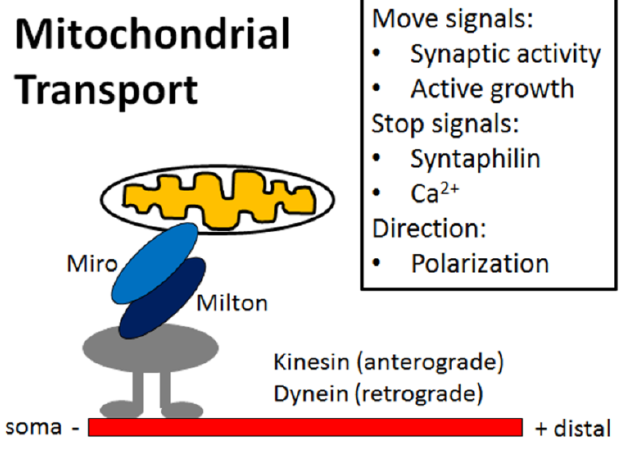
Figure 2. An illustration showing the transport of mitochondria from cell body to nerve terminal. Mitochondria are transported along microtubules and are attached to molecular motors by Miro and Milton. These two proteins provide important points of regulation for mitochondrial transport and may prove to mediate the signals for mitochondrial